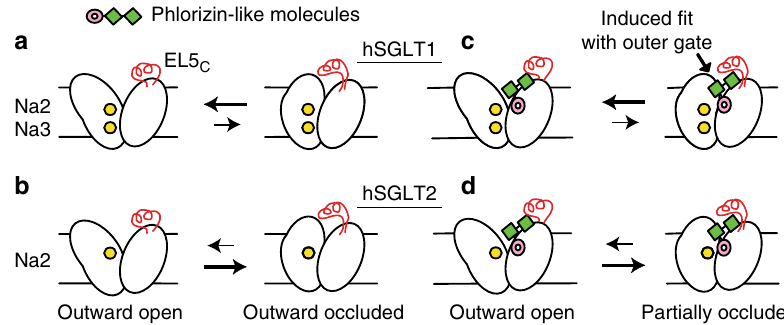
Fig. 5 Allosteric model of inhibitor binding to SGLTs. The binding of phlorizin-like inhibitors to the outward-facing state of SGLTs leads to a partial closure of the TM9-10 outer gate in an induced fi t mechanism. a , c Binding of 2 Na + to hSGLT1 stabilizes the outer gate in an open conformation making it less favorable for the gate to close over the aglycon tails of inhibitors. b , d The absence of the Na3 site in hSGLT2 makes partial closure and inhibitor binding more favorable and therefore the inhibitors more potent. Additionally, elements of EL5 C (red) contribute to better binding to